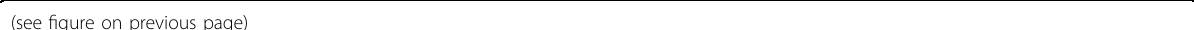
ing scores were retrieved from previous analysis 25 . AR sig-